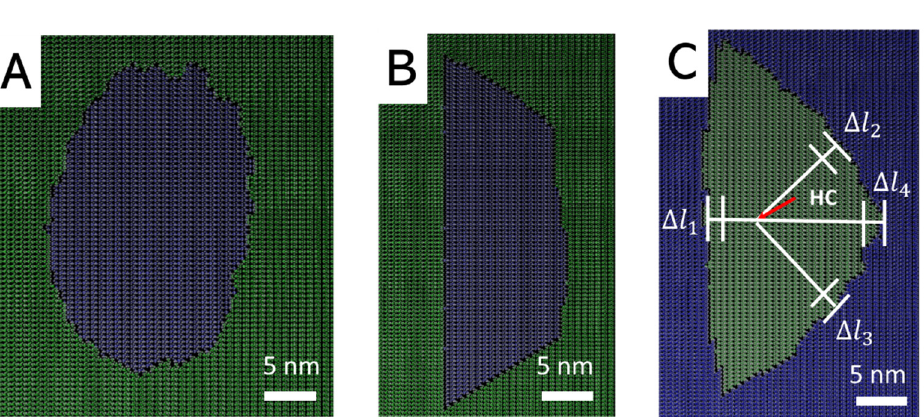
Table 1. Parameter sets for the Kinetic Monte Carlo model of barite dissolution; all parameters are provided in kT units, except 𝑣 , the reaction attempt frequency factor, which is given in Hz.